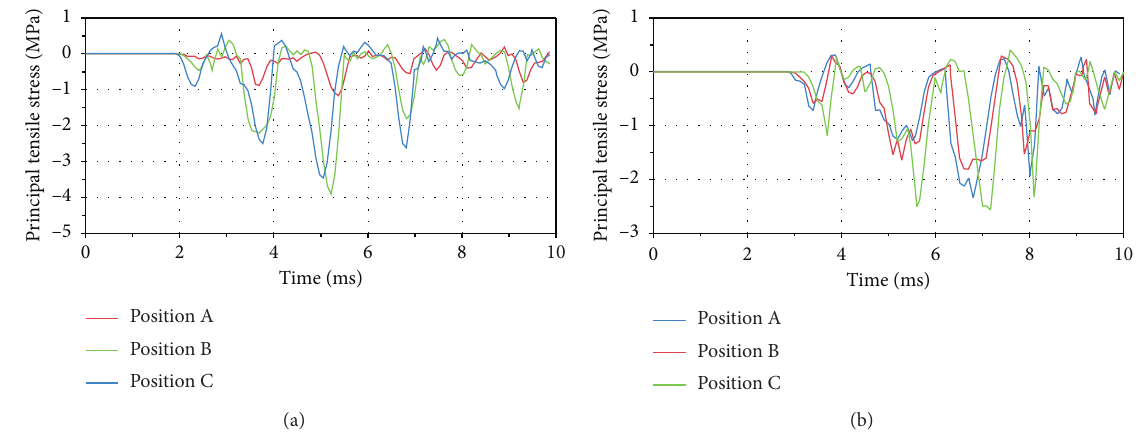
Figure 5: Principal tensile stress at different positions of the lower and upper steel plates. (a) Principal tensile stress curves at different positions of the lower plate. (b) Principal tensile stress curves at different positions of the upper